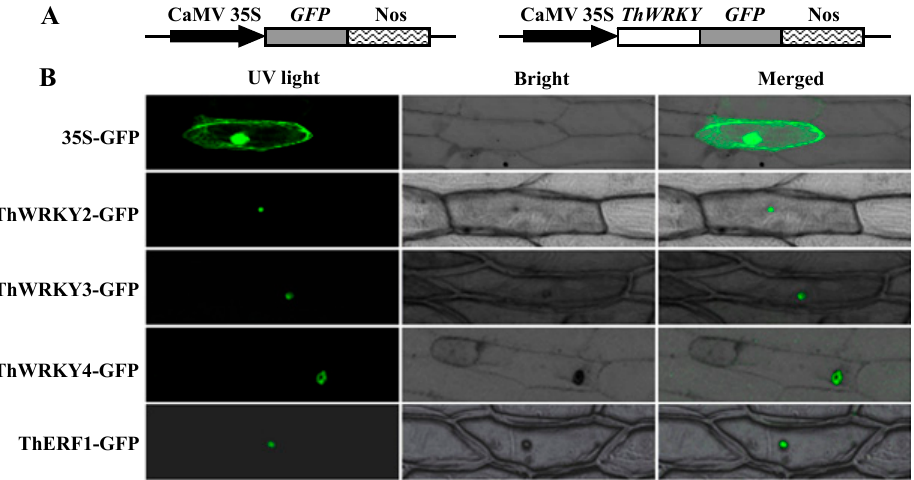
Figure 5. Nuclear localization of ThWRKY proteins. ( A ) Diagram of the 35S-GFP control construct and recombinant plasmid pBI121-ThWRKY-GFP; ( B ) The ThWRKY-GFP fusion gene and GFP (control) were transiently expressed in onion epidermal cells by the particle bombardment (Bio-Rad, Hercules, CA, USA) method. The transformed cells were cultured on MS medium for 24–36 h and visualized using a confocal microscope at 488 nm (LSM410, Zeiss, Jena, Germany). An ethylene-responsive factor from T . hispida , ThERF1, is a nuclear protein according to Wang et al. [37], which was used as a positive control.